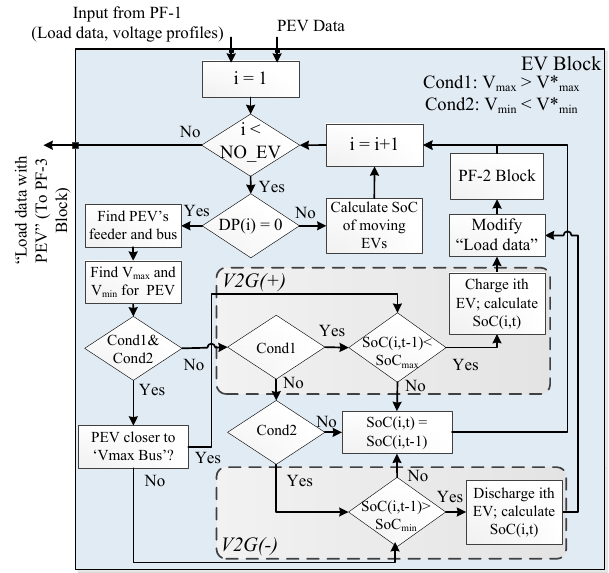
Figure 4. Proposed algorithm for vehicle to grid (V2G) application of electric vehicles (EVs).